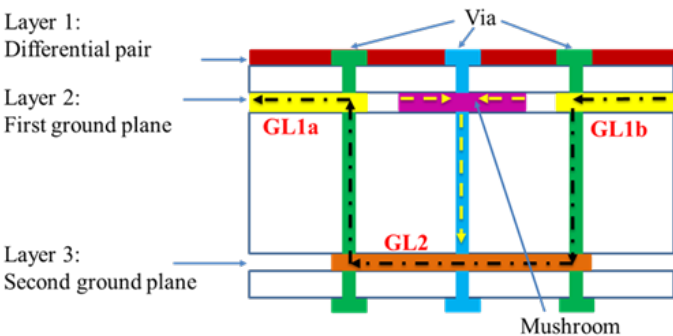
Figure 3. The CM current return path of the differential pair transmission signal.